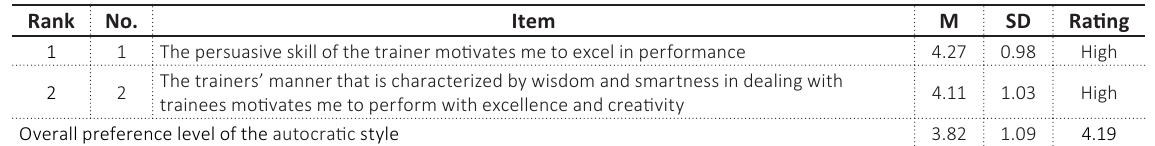
Table 7. Means and standard deviations of respondents’ responses to items measuring the autocratic style in descending order of means